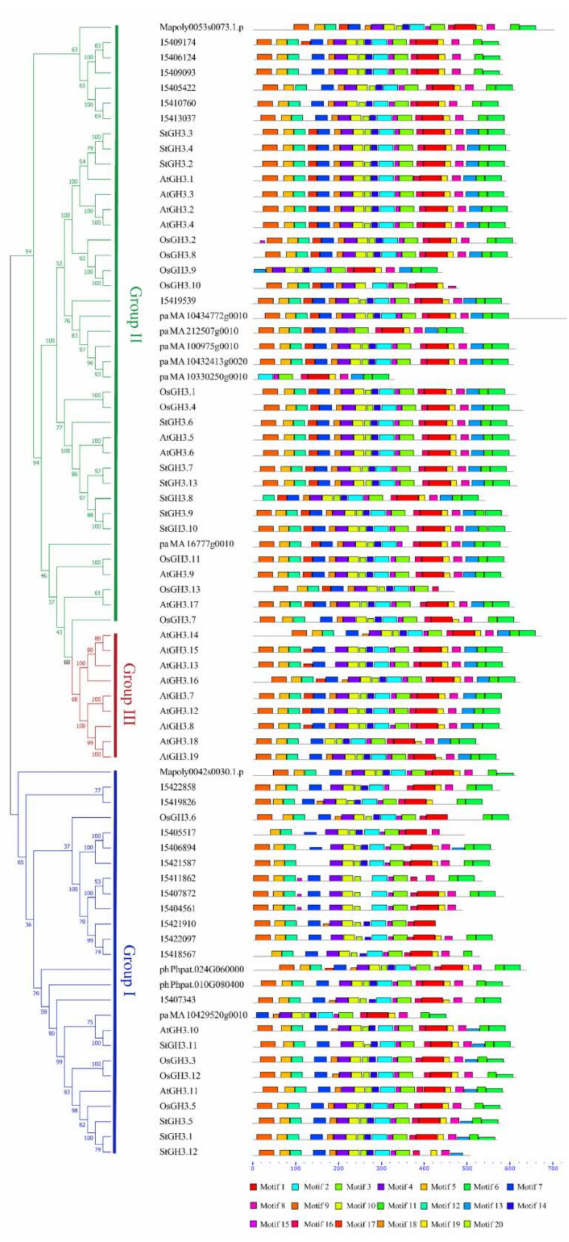
Figure 2. Gene motifs of seven plant species. The species belong to different lineages, including M.a polymorpha L., P. patens , S. moellendorffii , P. abies , S. tuberosum , A. thaliana and O. sativa . On the left, the protein name and phylogenetic tree are shown. The different color boxes indicate 20 motifs, which were found by using the MEME